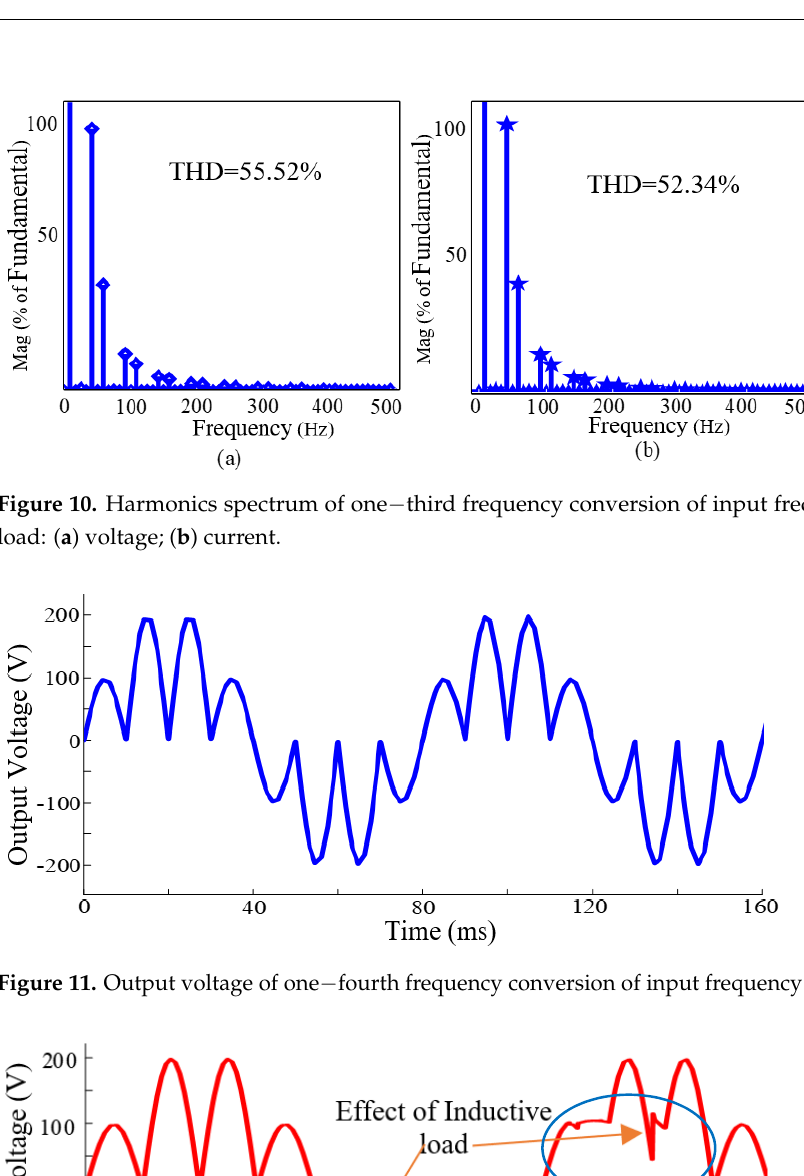
Figure 9 . Output current of one − third frequency conversion of input frequency for motor load.